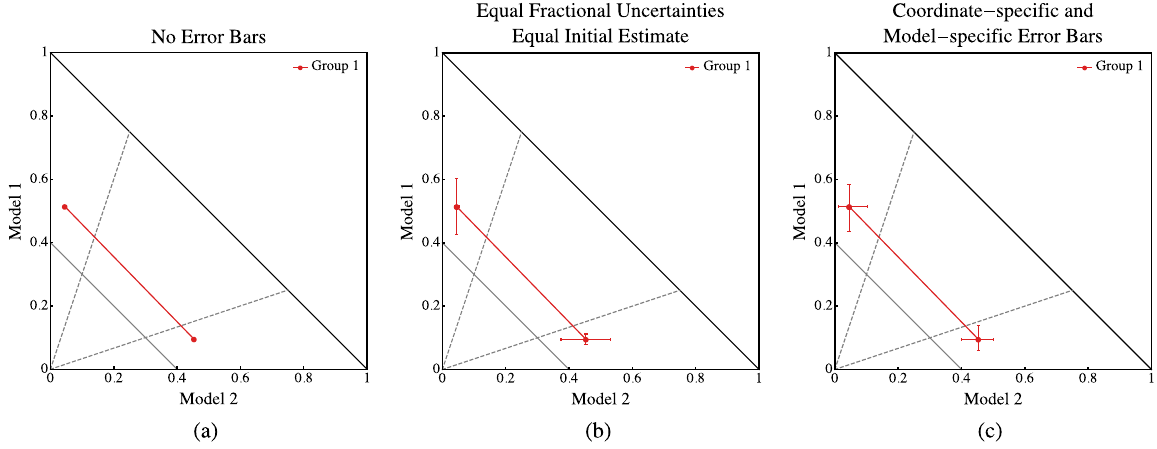
FIG. 2. Model plots for the example data: (a) no error bars, (b) assuming equal fractional uncertainties for both coordinates and equal initial error estimates for all models (pooled standard error), and (c) assuming coordinate-specific uncertainties and model-specific initial error estimates (standard error of the distribution for each